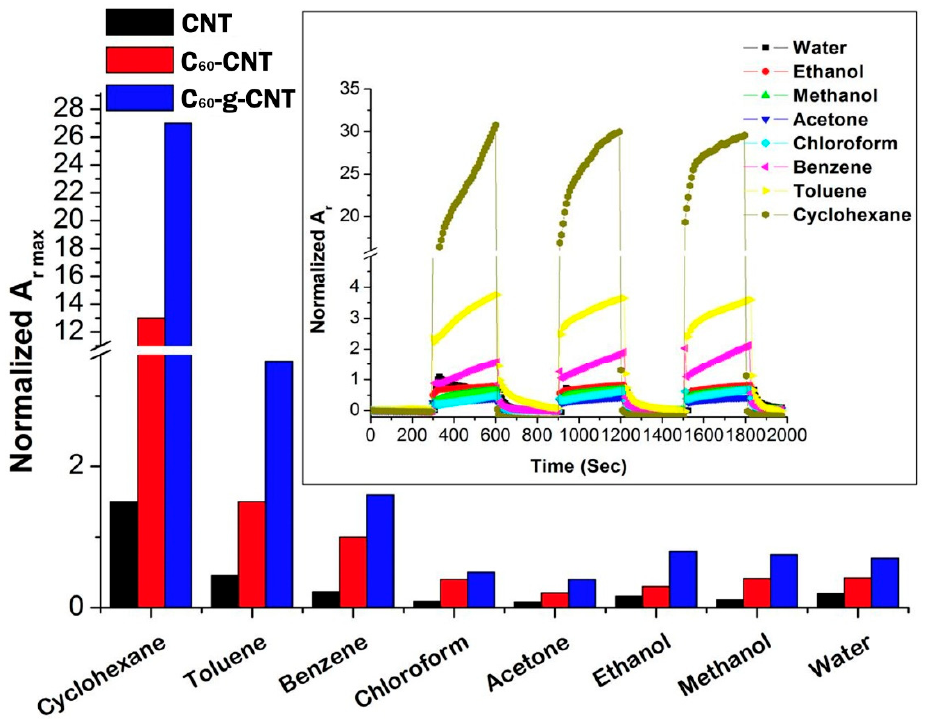
Figure 5. Normalized average maximum relative amplitude Ar of 3 kinds of sensors towards 8 VOC (equivalent to 1000 ppb concentration). The inset image shows the chemo-resistive response of the C 60 -g-CNT sensors towards 8 VOC.